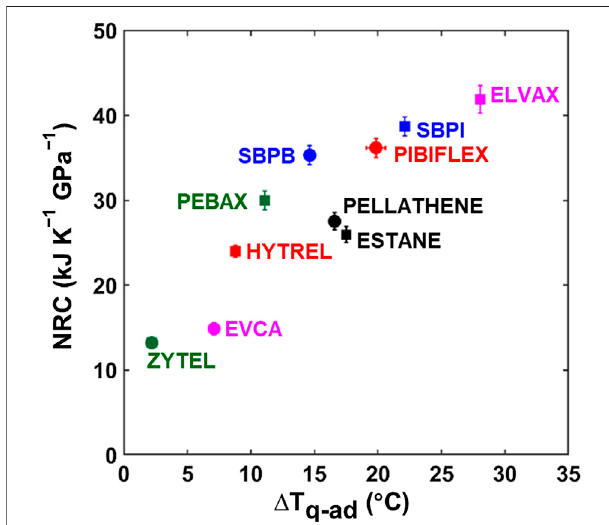
FIGURE 7 | Direct versus indirect barocaloric measurement. Comparison of the normalized refrigeration capacity (NRC, for Δ p = 100 MPa and Δ T h − c = 65 ° C) evaluated based on pvT measurements and the quasi- adiabatic temperature change ( Δ T q − ad ) measured ( Δ p = 434.1 MPa) using the custom test rig for the materials tested.